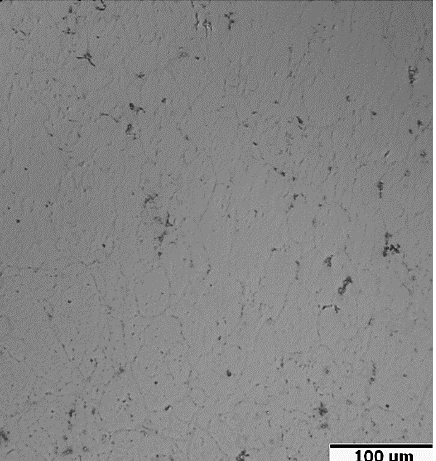
Figure 8. Typical microstructure of the compacts made of Alumix 431D powder containing 1.5 mass% of Acrawax C sintered at a nitrogen linear flow of 120 cm/min.